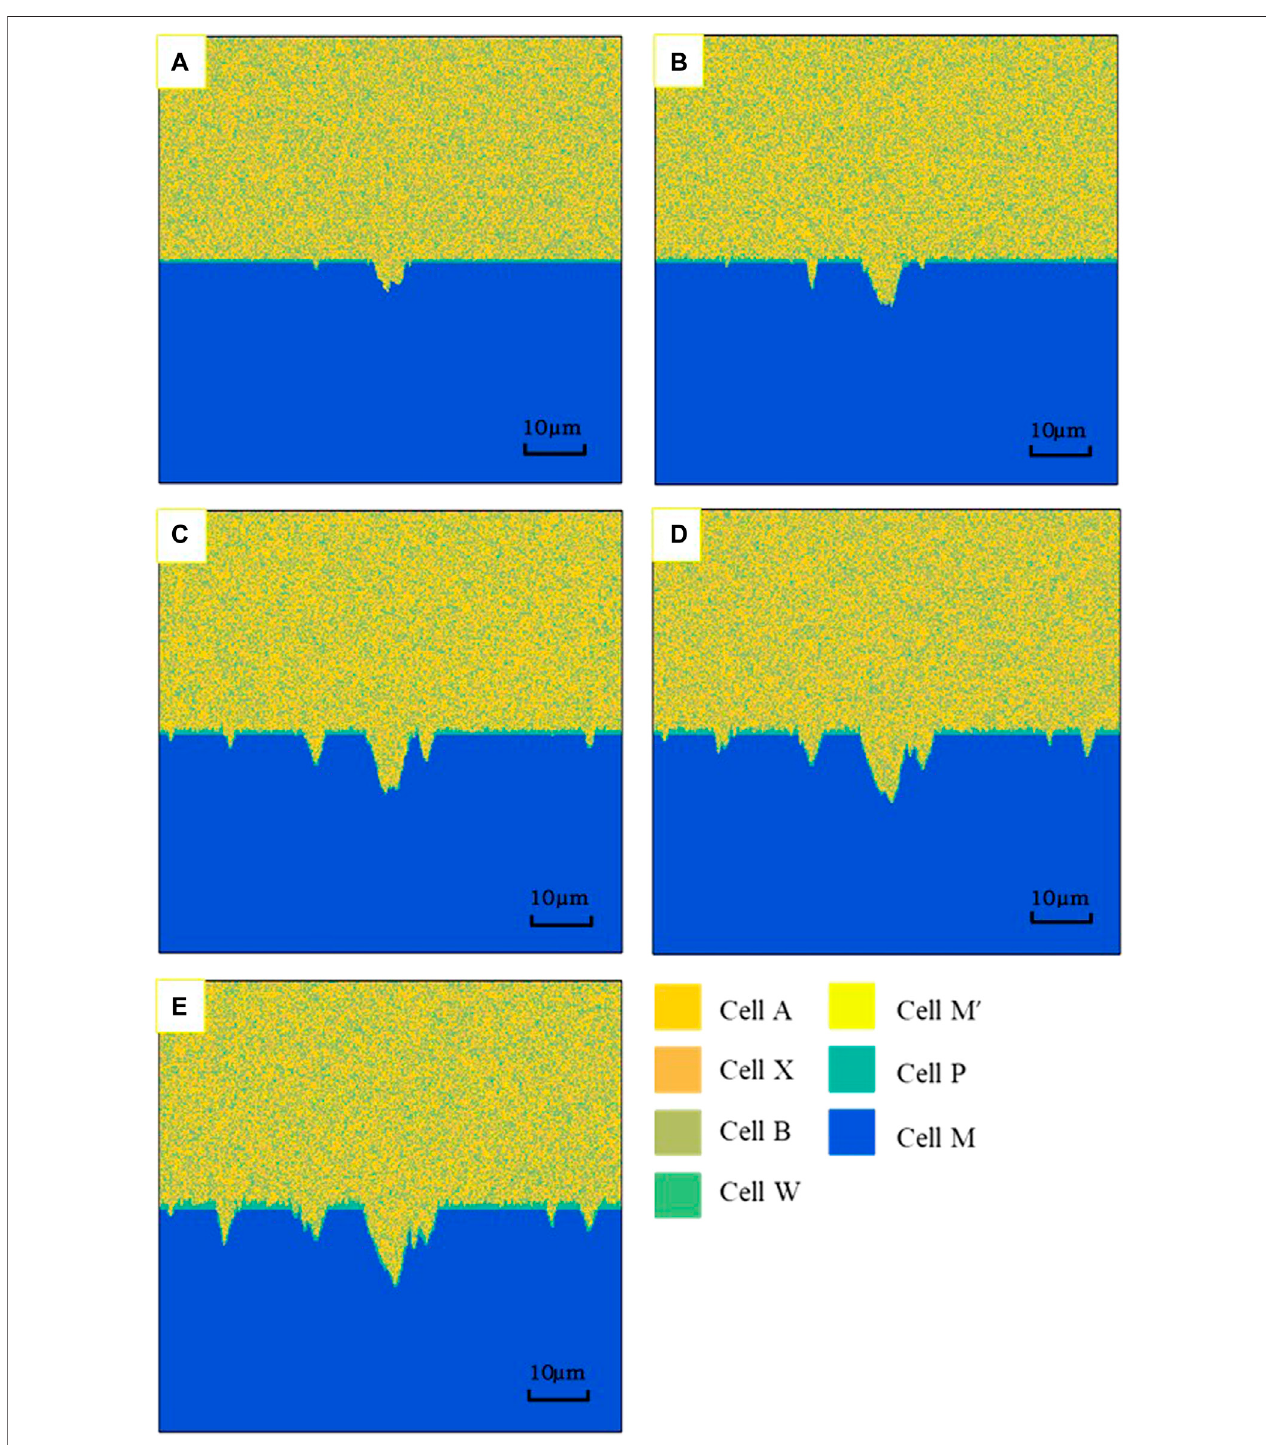
FIGURE 14 | Morphology of different corrosion times simulated by CA. (A) 30 days, (B) 60 days, (C) 180 days, (D) 240 days, (E) 300 days.